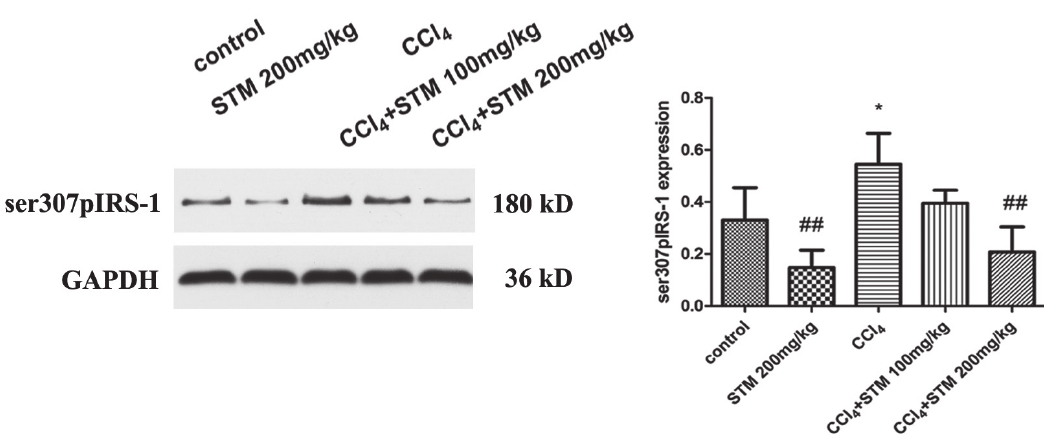
FIGURE 5 - STM downregulated pIRS-1. The expression level of the ser307pIRS-1 in liver tissue was significantly elevated in the CCl group as compared with the control group ( p < 0.05). STM (200 mg/kg b.w.) treatment downregulated the ser307pIRS-1 4 level notably in liver as compared with the CCl group ( p < 0.01). Data are represented as means ± S.D. for 3-4 animals per group. 4 * p < 0.05 versus control, ** p < 0.01 versus control; # p < 0.05 versus CCl , ## p < 0.01 versus CCl by one-way ANOVA and LSD 4 4 post hoc